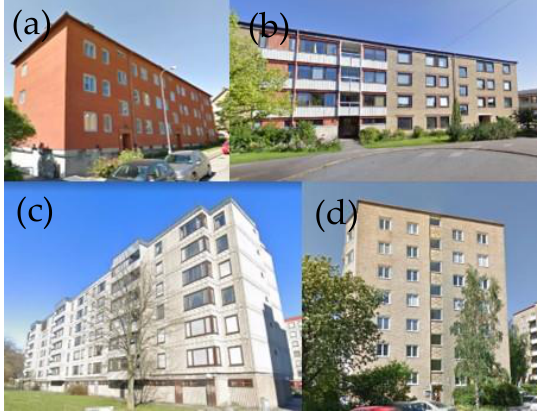
Figure 2. Representative building types 1945–1975: ( a ) slab block from 1945–1960; ( b ) slab block from 1960–1975; ( c ) panel block and ( d ) tower block.